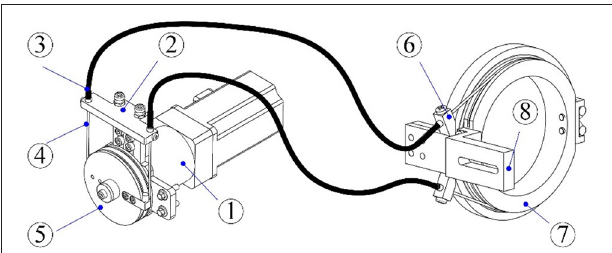
FIGURE 2 | Schematic of the Bowden-cable actuation system (1-Servo motor and planetary gear reducer; 2-Pretension device; 3-Outer sheath; 4-Inner cable; 5- Proximal pulley; 6-Cable supports; 7-Distal pulley; 8-Exoskeleton link).